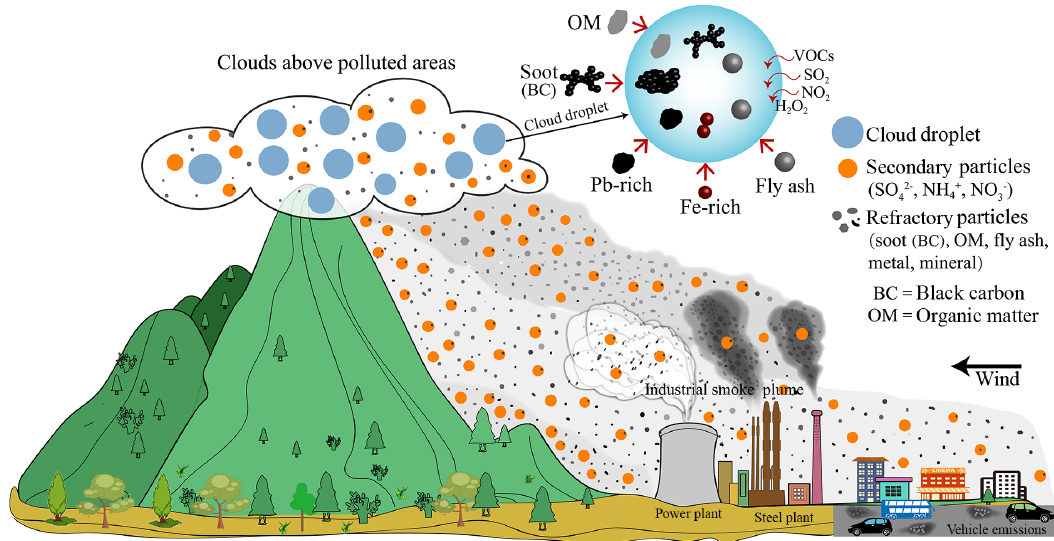
Figure 9. A conceptual model illustrating mechanisms of aerosol–cloud interactions on a mountaintop influenced by anthropogenic pollutants from heavy industrial and urban